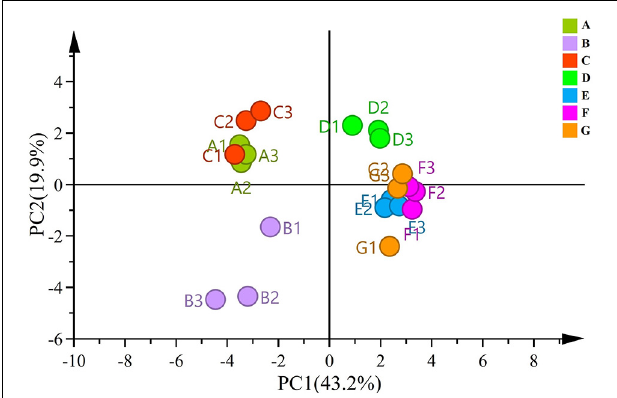
FIGURE 2 | PCA plots based on unweighted UniFrac distance metrics for fungal communities.